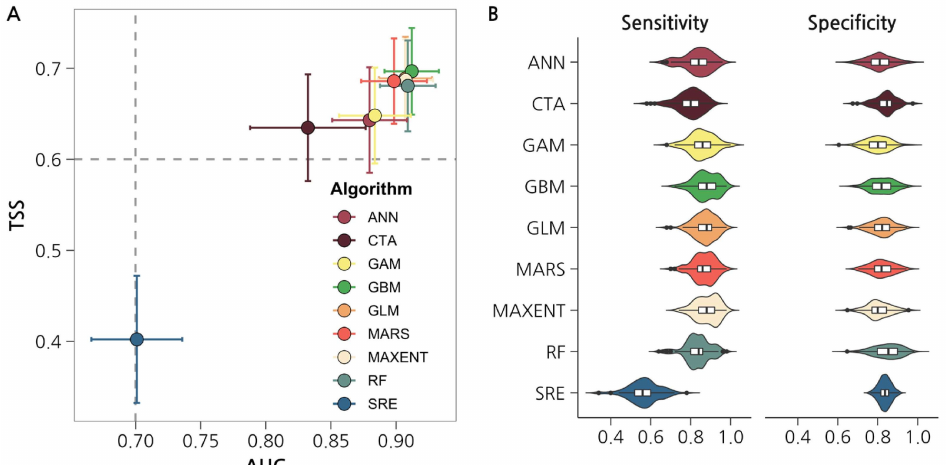
Figure 2. Validation metrics for the single algorithm models: AUC and TSS ( A ) and sensitivity and specificity ( B ). The points and crosses represent the mean and standard deviation of the AUC and TSS metrics for 100 models of each algorithm. The boxplots show the mean and interquartile range of the sensitivity and specificity, while the violin plots show the distribution of the sensitivity and specificity for 100 models of each